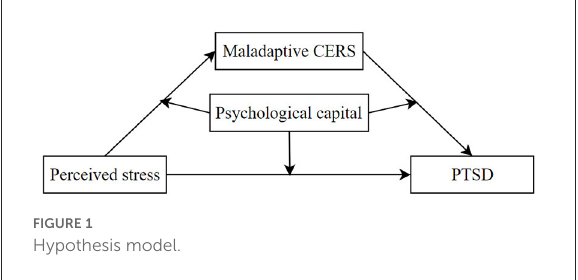
FIGURE1 Hypothesis